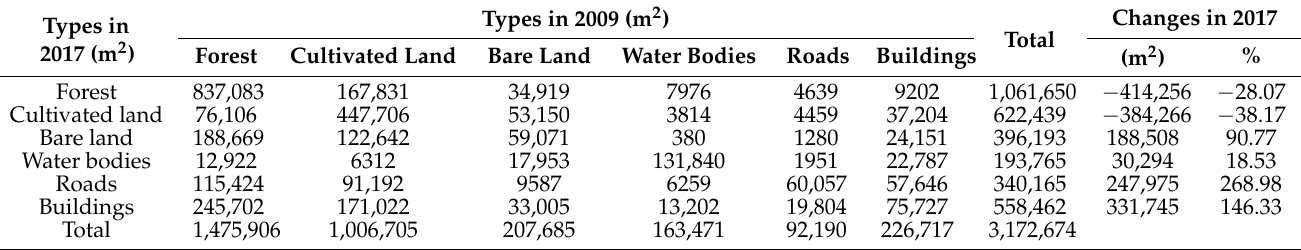
Table 6. Change matrix of six types of surface objects from 2009 to 2016 in experiment two in the study area A. Types in 2016 (m 2 )